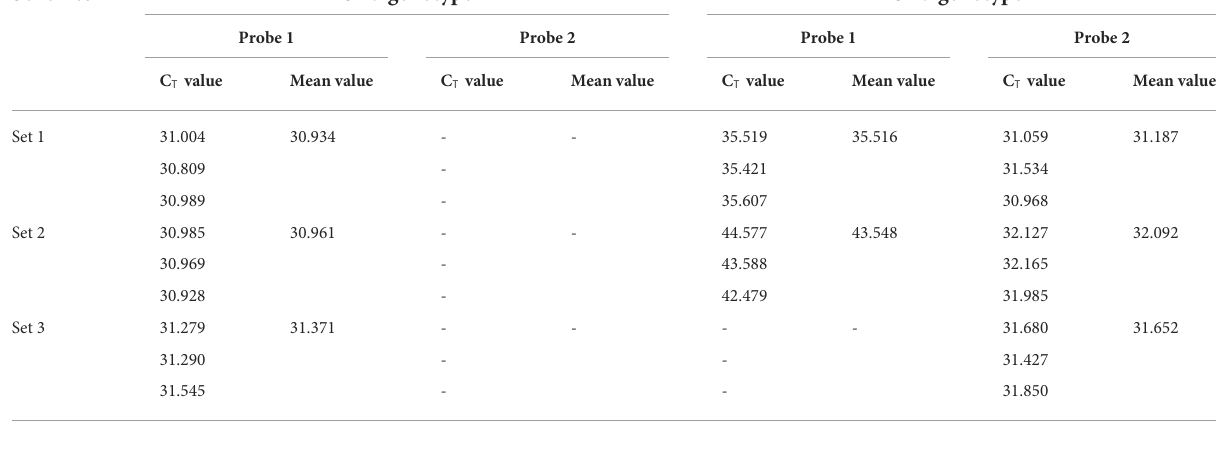
TABLE 1 Comparison of the efficiencies of the primer/probe sets of the duplex fluorescence quantitative PCR. Schemes